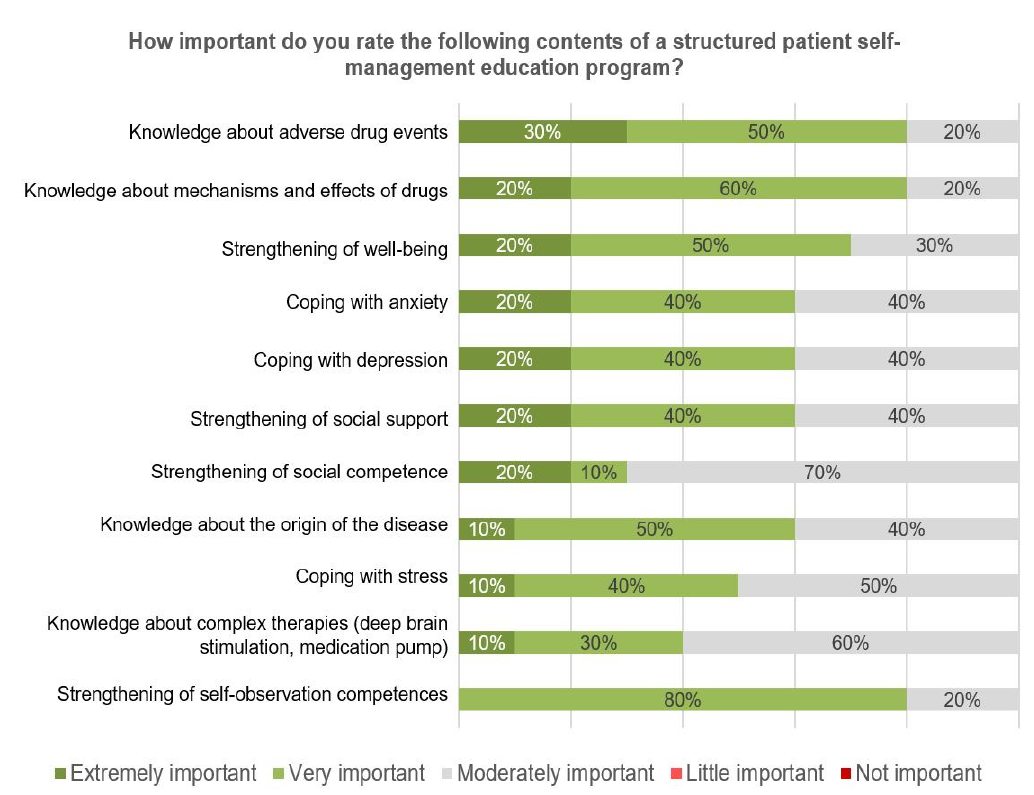
Figure 6. Survey results—importance of the contents of a structured patient education program ( n = 10).